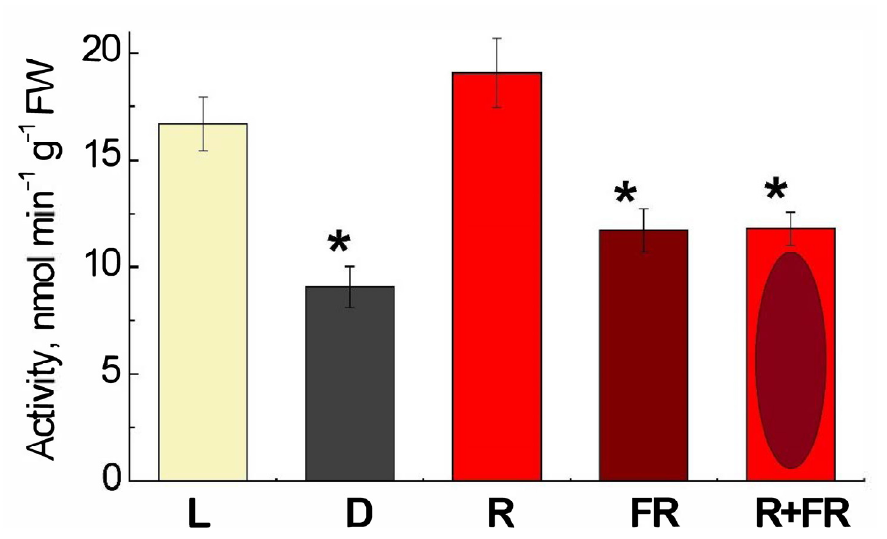
Figure 4. Changes in the activity of DNA adenine methylase in maize leaves under different lighting conditions. Data are the means of three biological repeats ± SD. Asterisks indicate significant differences at p < 0.05. Abbreviations: L, plants illuminated with white light; D, plants kept in darkness; R, plants illuminated with red (660 nm) light; FR, plants illuminated with far-red (730 nm) light; R+FR, plants illuminated with red (660 nm) followed by far-red (730 nm) light.